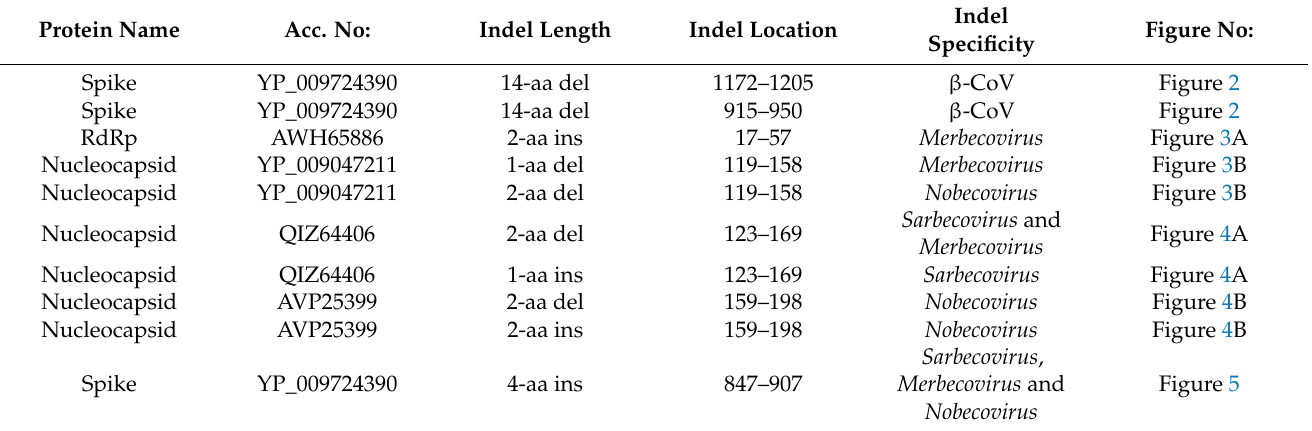
Table 1. Conserved signature indels found in spike, nucleocapsid, and RNA-dependent RNA polymerase (RdRp) proteins that are specific for various members of lineages of